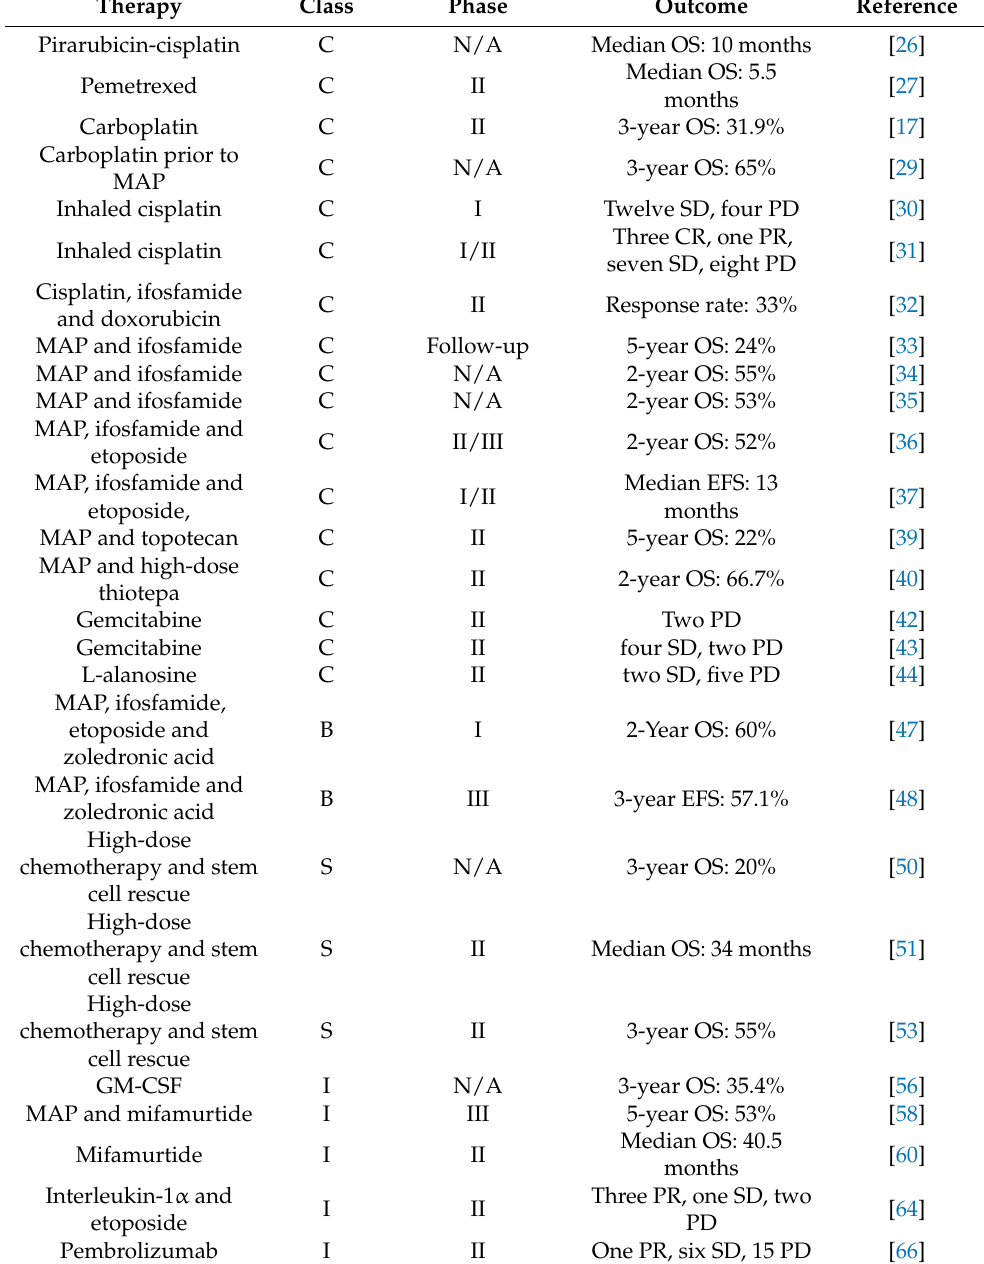
Table 1. Summary of metastatic osteosarcoma clinical trials and their outcomes. Class of the inves- tigational agent on which the study focused: C, chemotherapy; B, bone modifying agents; S, stem cell rescue; I, immunotherapy; T, tyrosine kinase inhibitors; O, other drug therapies. Responses: CR, complete response; PR, partial response; SD, stable disease; PD, progressive disease. OS, overall survival; PFS, progression free survival; EFS, event free survival. Therapy Class Phase Outcome Reference N/A Median OS: 10